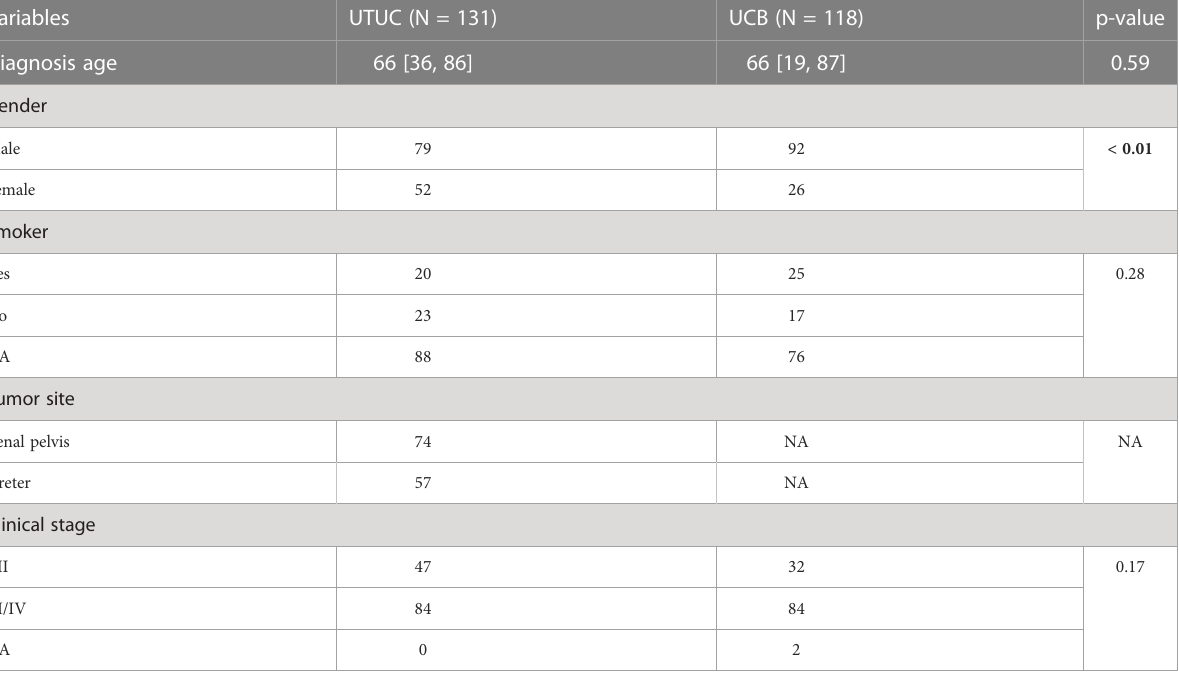
TABLE 1 UTUC and UCB patient characteristics in Chinese cohort.